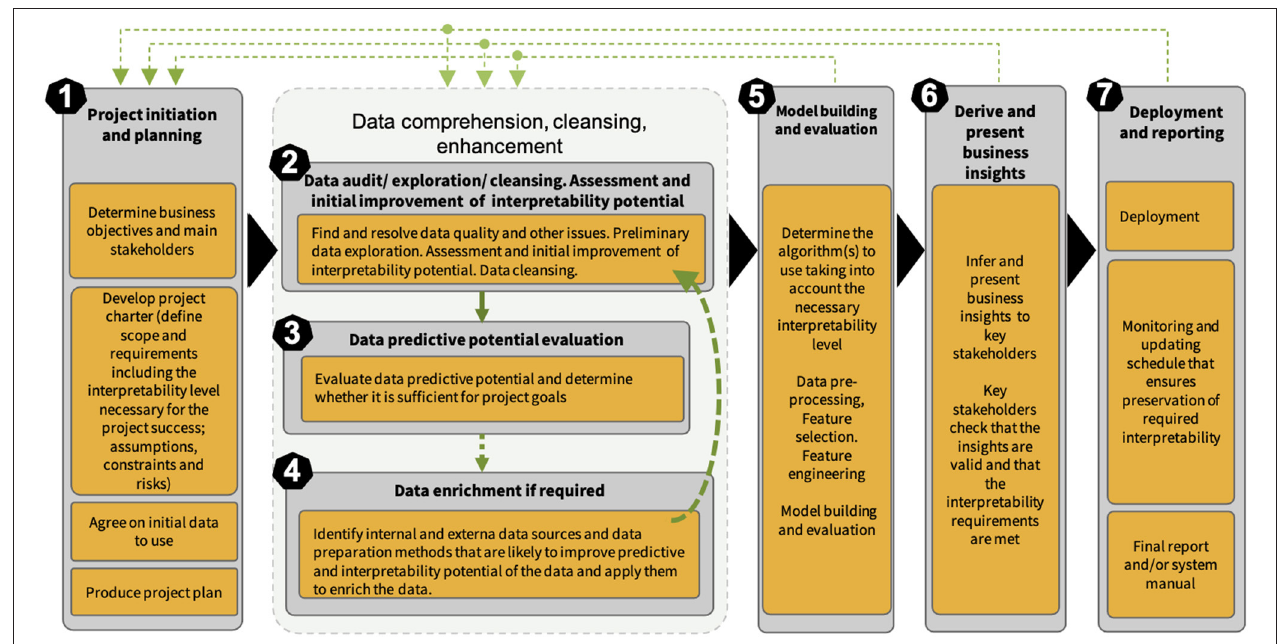
FIGURE 1 | Conceptual framework of CRISP-ML